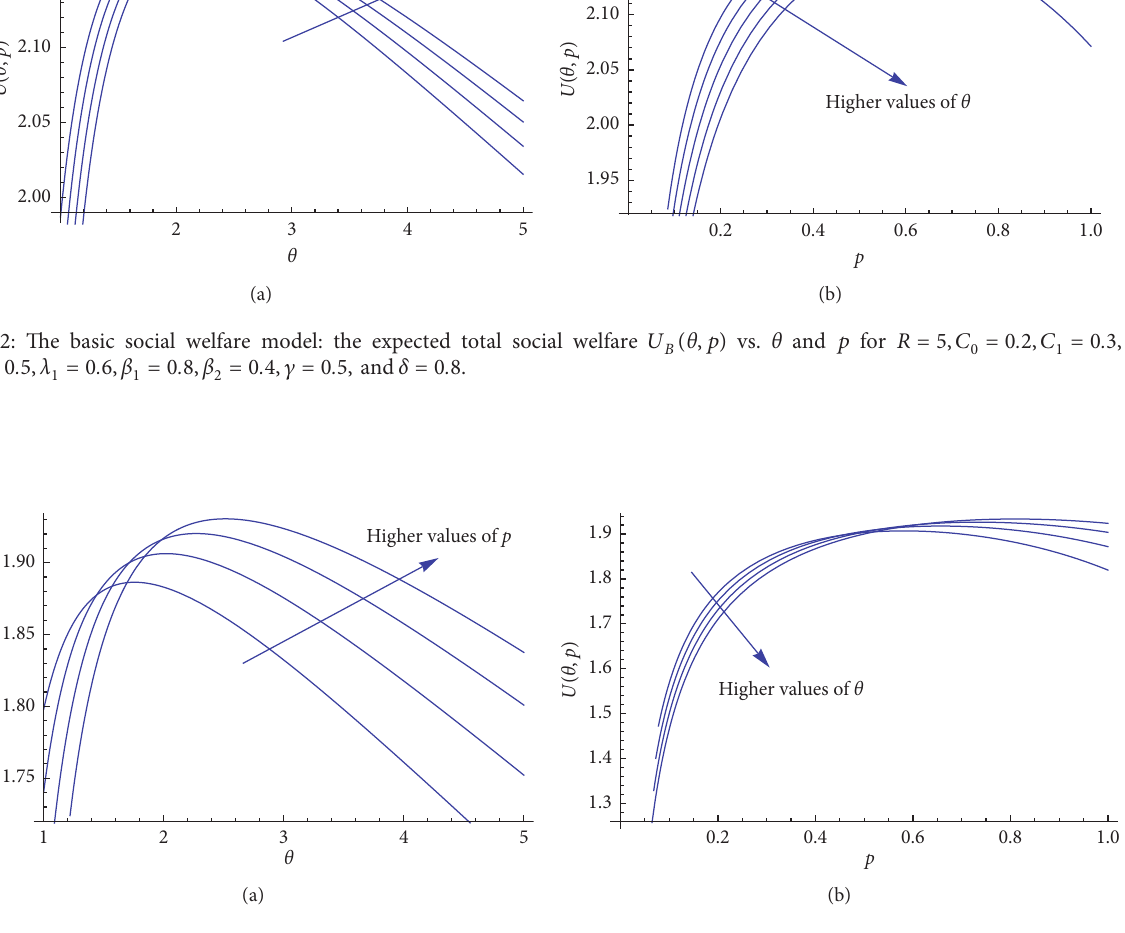
( θ ,p ) vs. θ and p for R � 5 ,C E